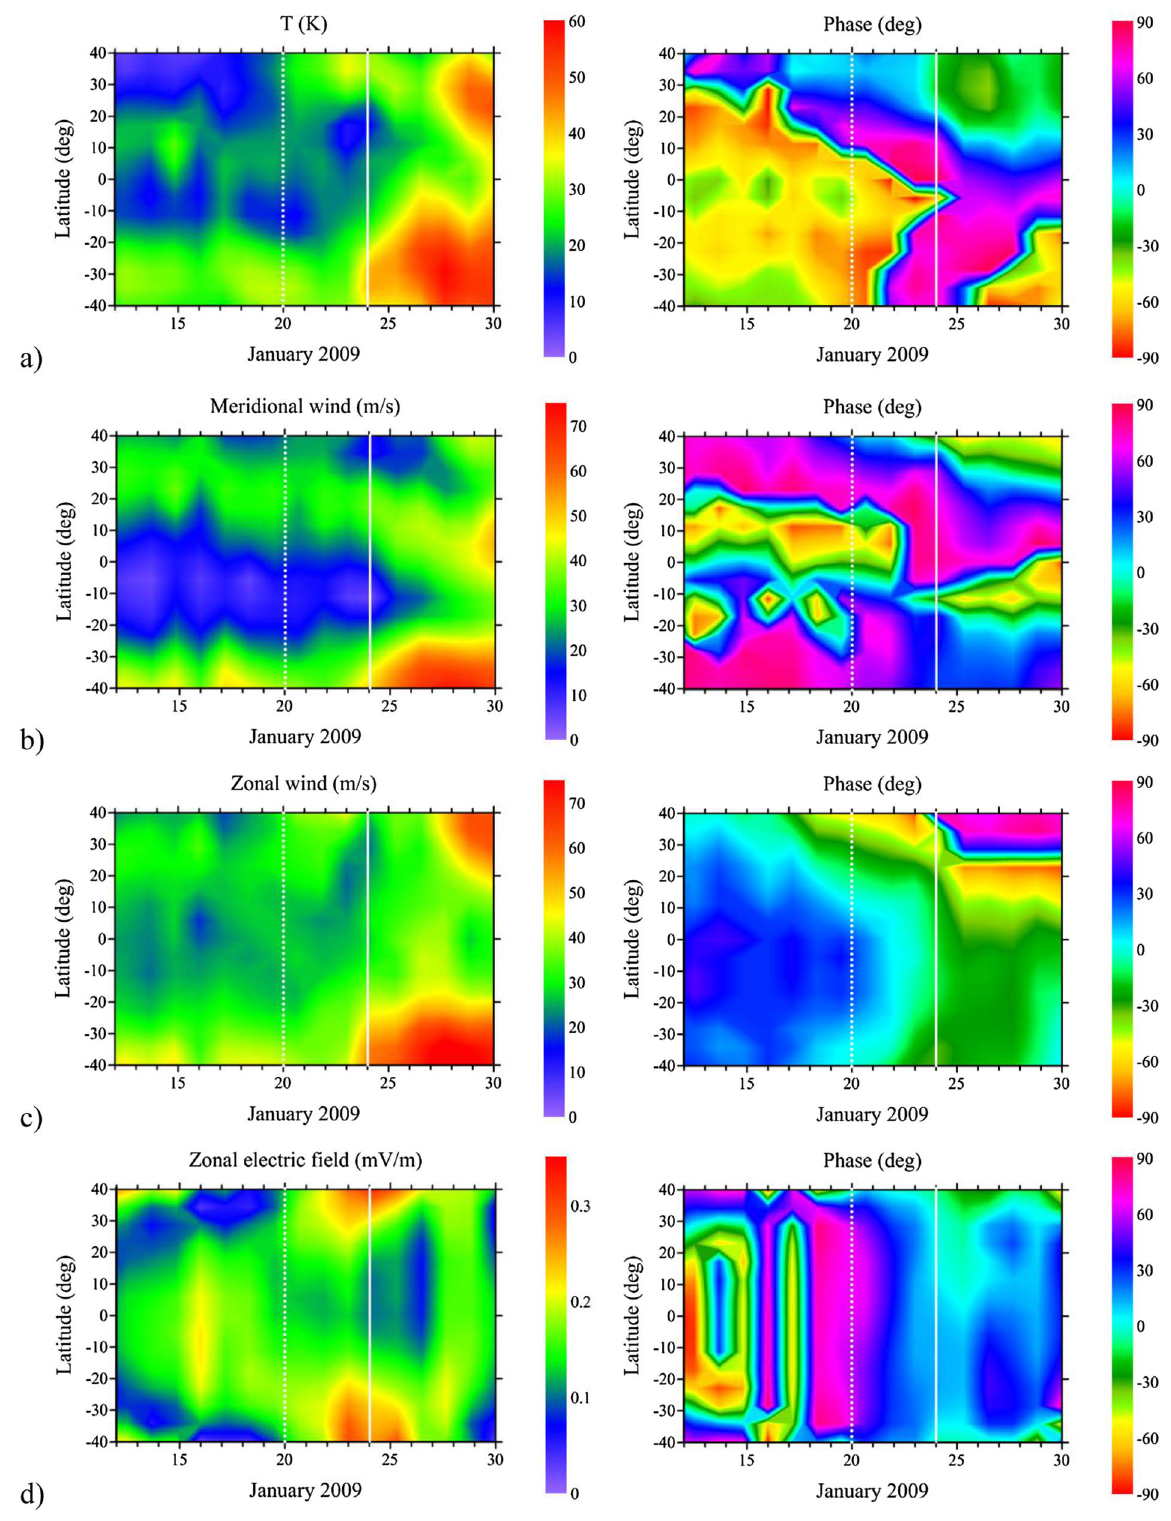
Fig. 10. Magnitudes (left panels) and phases (right panels) of the semidiurnal migrating solar tide in the (a) neutral temperature, (b) meridional wind, and (c) zonal wind at 114 km altitude as well as (d) the zonal electric fi eld simulated with EAGLE. Vertical lines indicate the onset (dotted) and peak (solid) of the 2009